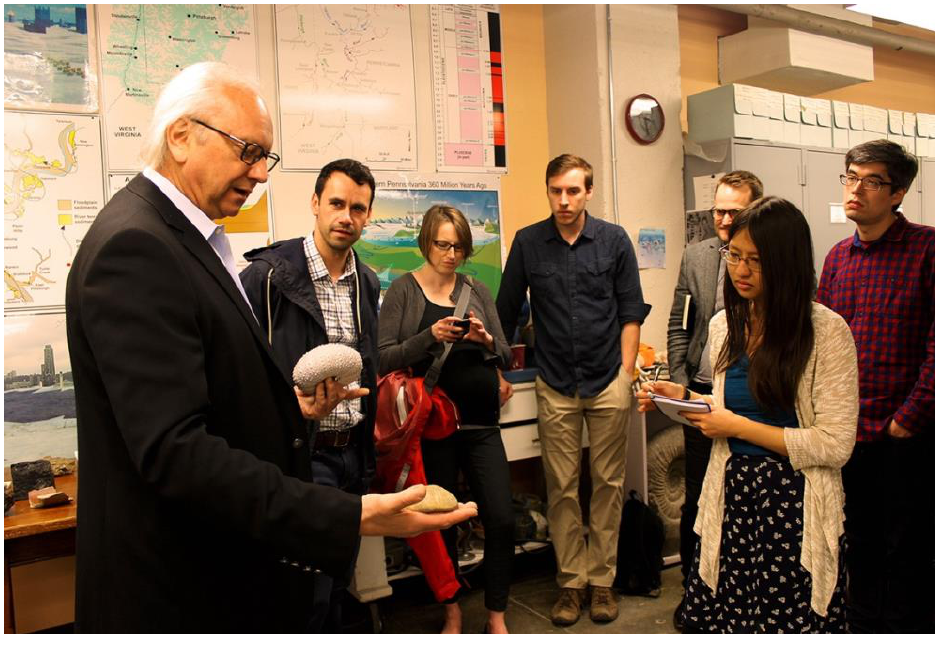
Consuming Nature Workshop participants at CMNH, May 2017. (Photo: Ana Rodríquez Castillo)